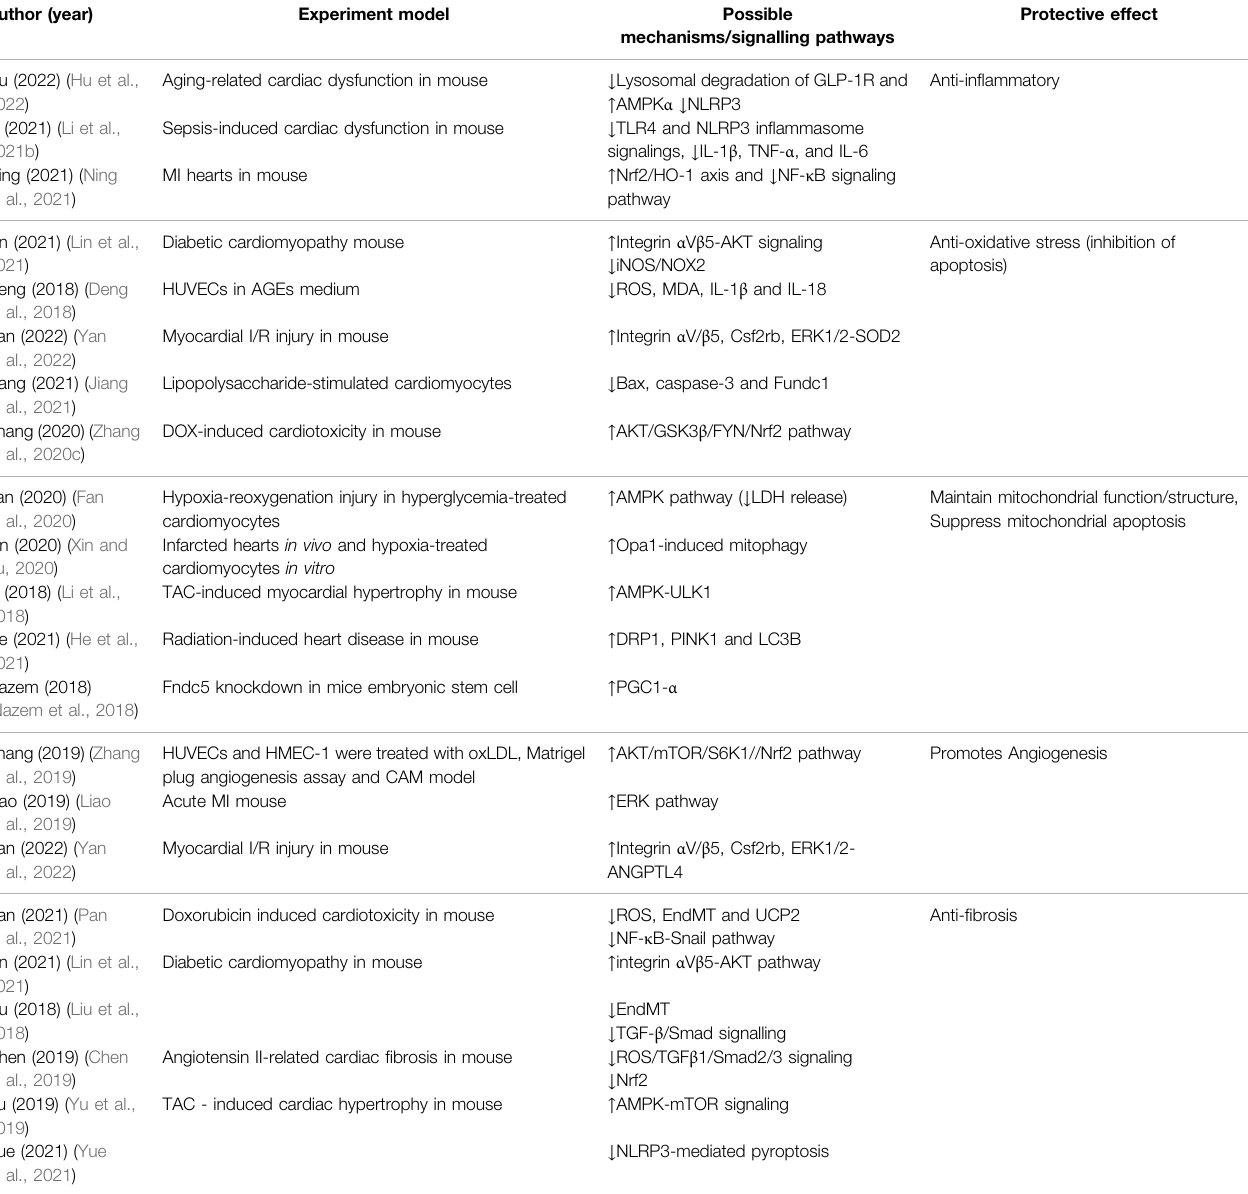
TABLE 4 | Possible mechanisms of the protective effect of irisin against